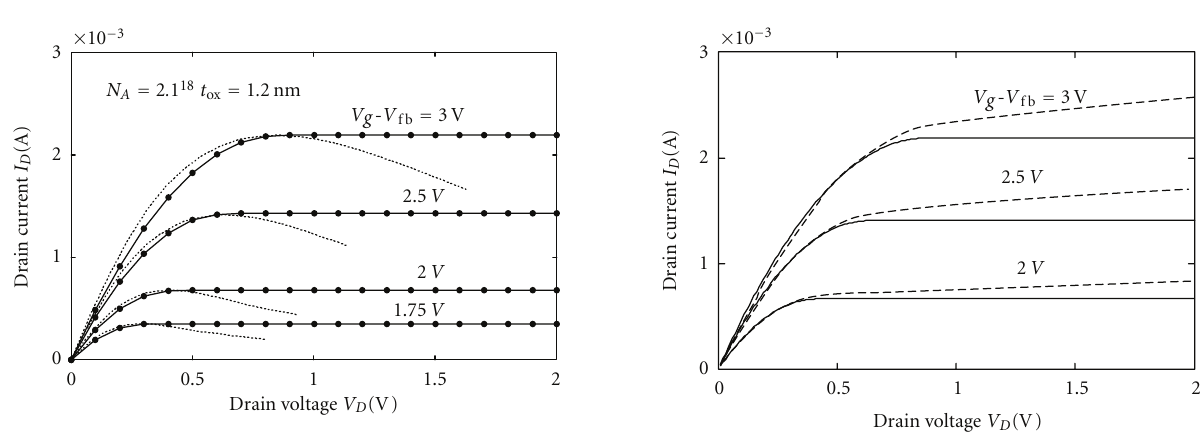
− ) (43), (--) (47). ( L = 90nm; W/L = 10.)